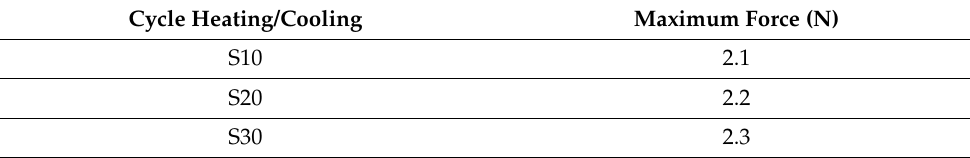
Table 2. Maximum force function of the thermal cycle (NiTi